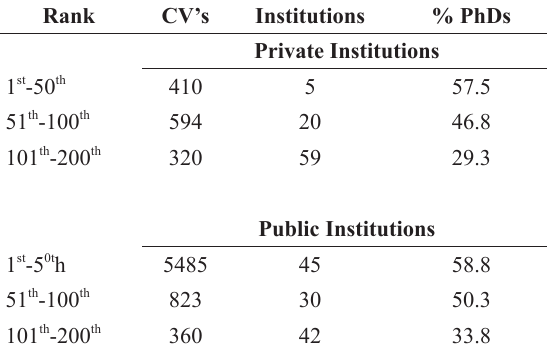
Distribution of doctorates among type of institutions and prestige ranks. Percentage of PhDs refers to number of CV per institution, per